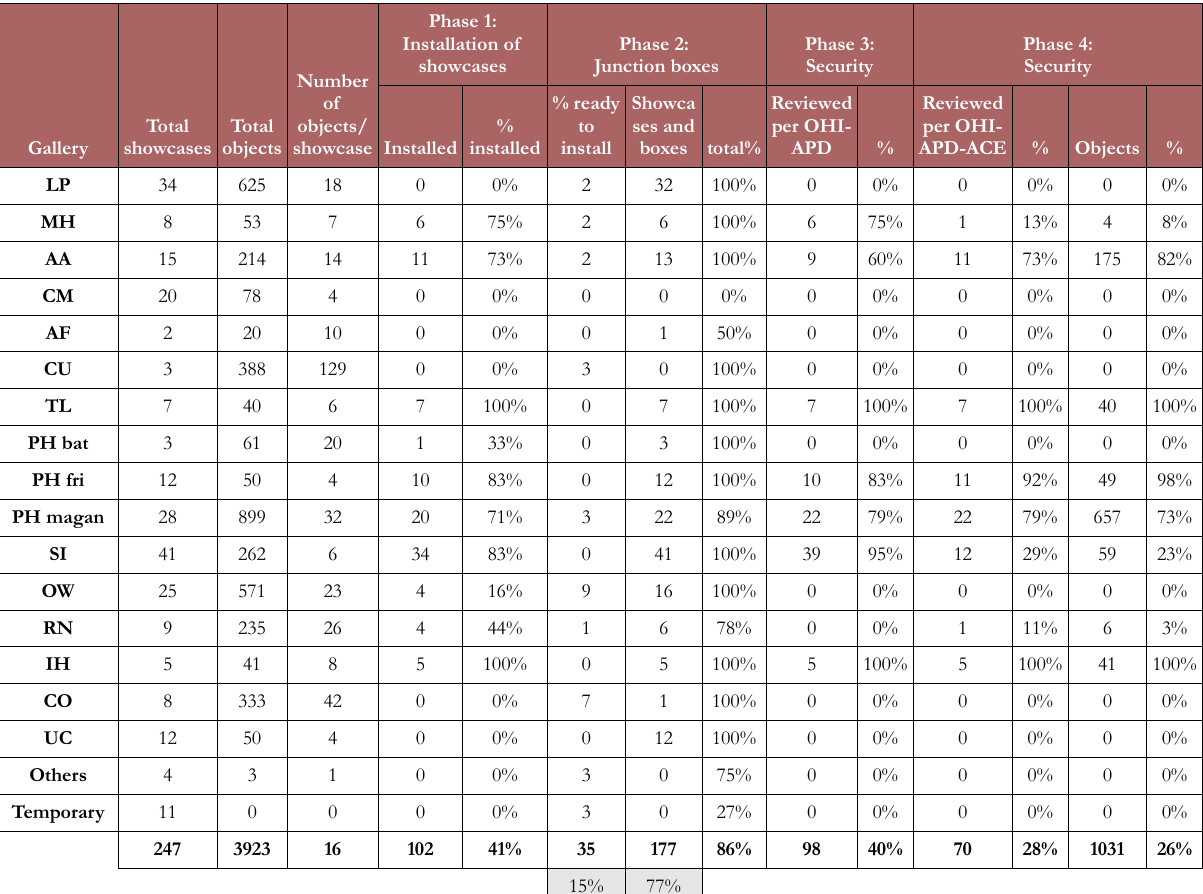
Table 6. Display control milestones for cabinets and security elements